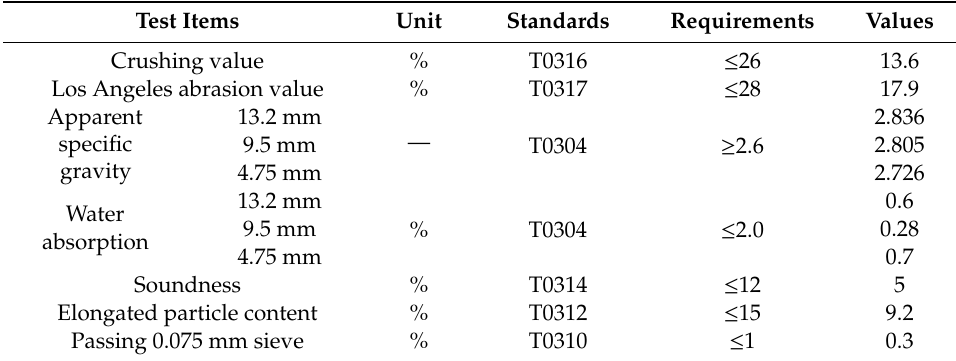
Table 2. Technical properties of basalt coarse aggregates.